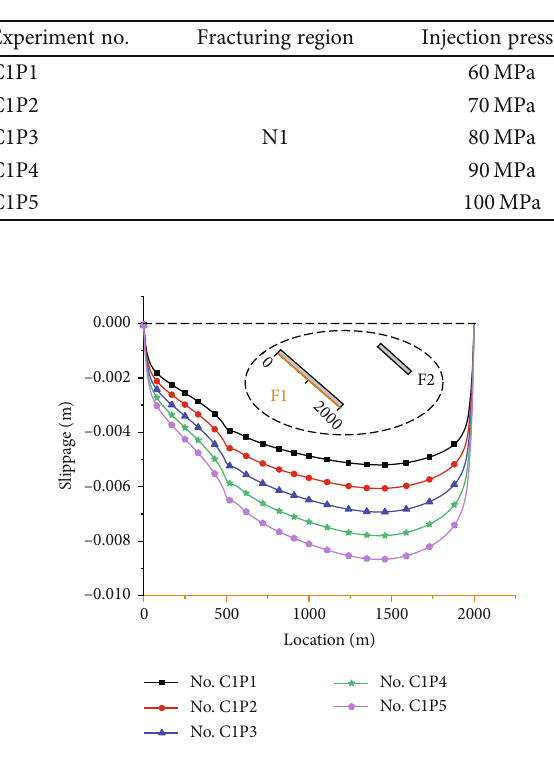
Figure 17: The fault slippage of F1 of di ff erent injection pressures (Nos. C1P1-C1P5).